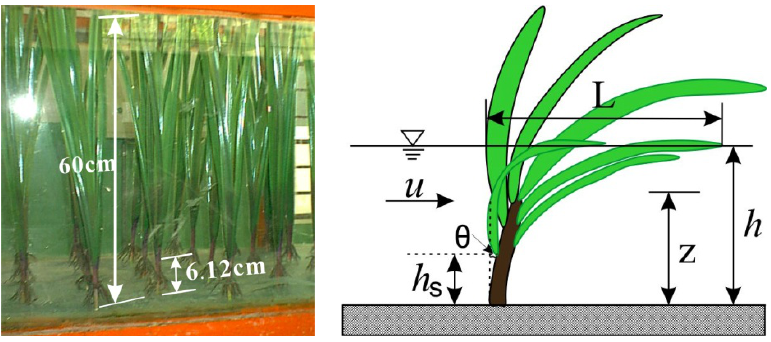
Figure 1. Geometry and notation of simulated A. calami in flow.